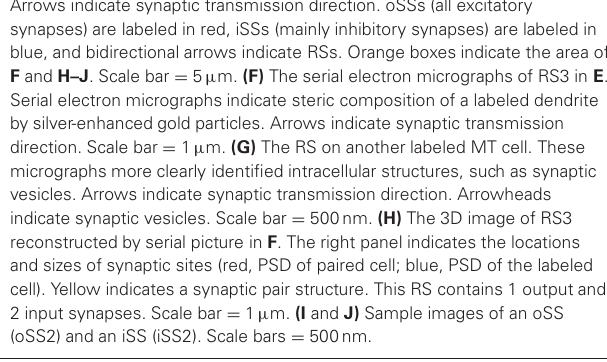
vesicles. Arrows indicate synaptic transmission direction. Arrowheads indicate synaptic vesicles. Scale bar = 500nm. (H) The 3D image of RS3 reconstructed by serial picture in F . The right panel indicates the locations and sizes of synaptic sites (red, PSD of paired cell; blue, PSD of the labeled